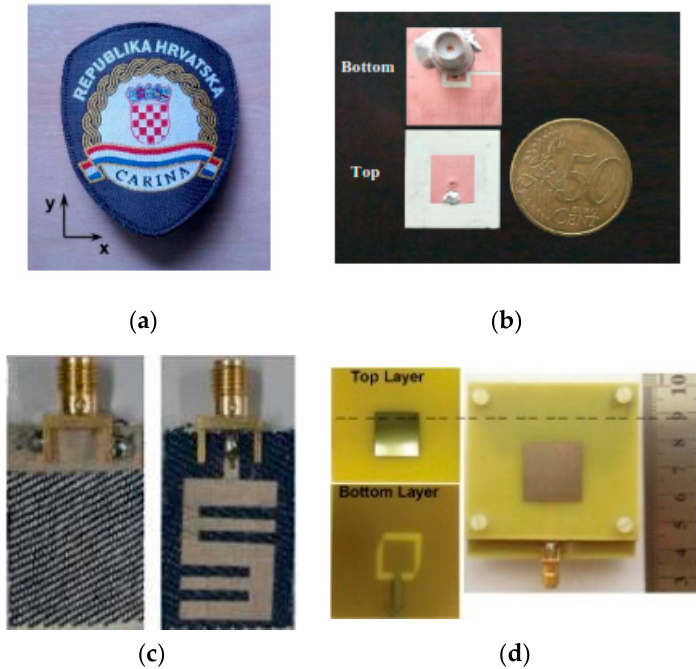
Figure 10. ( a ) Sleeve-badge antenna [285], ( b ) miniaturized dual band antenna with DGS [287], ( c ) E-shaped patch antenna [16], and ( d ) circular-polarized antenna [290].